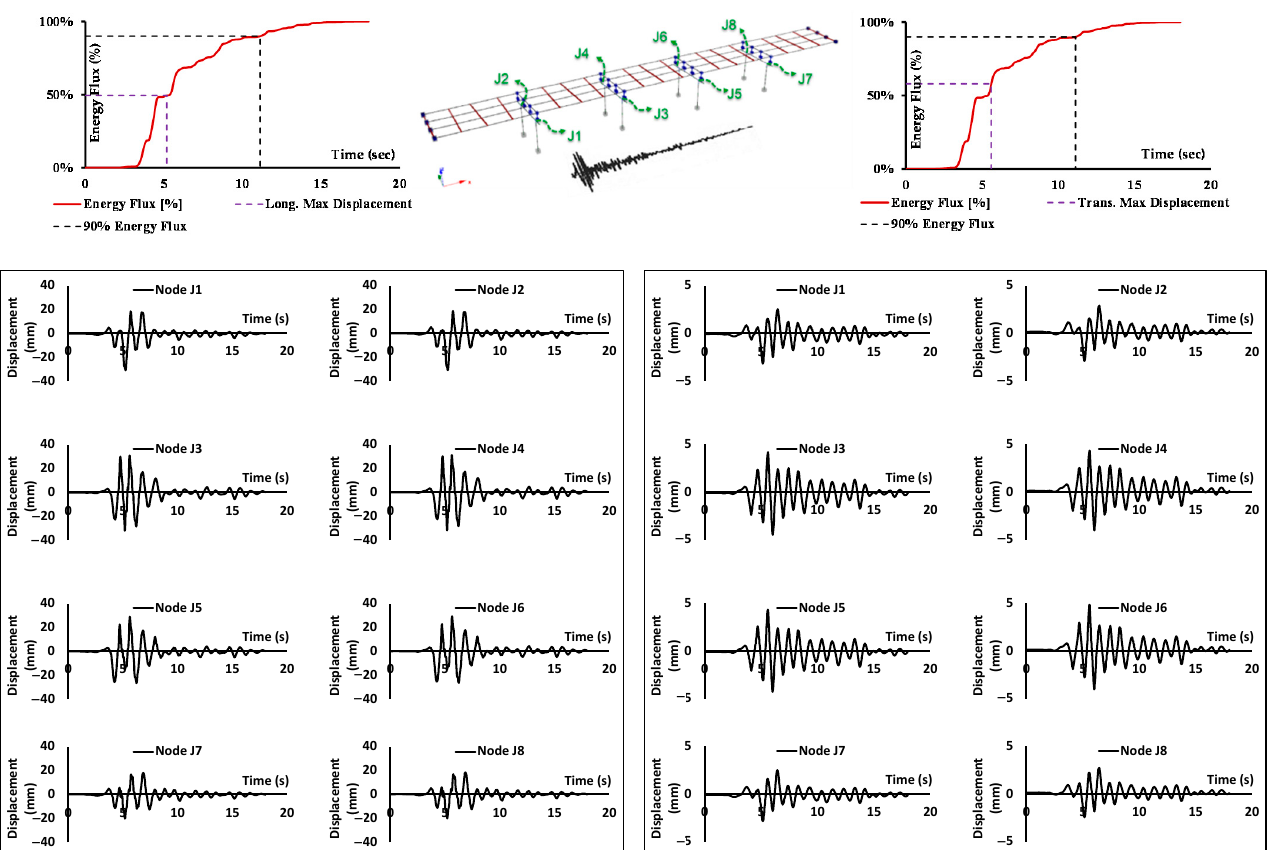
Figure 15. Seismic energy and top displacement histories under the far-field earthquake Bucharest in the longitudinal ( left ) and transverse ( right ) directions—design intensity.